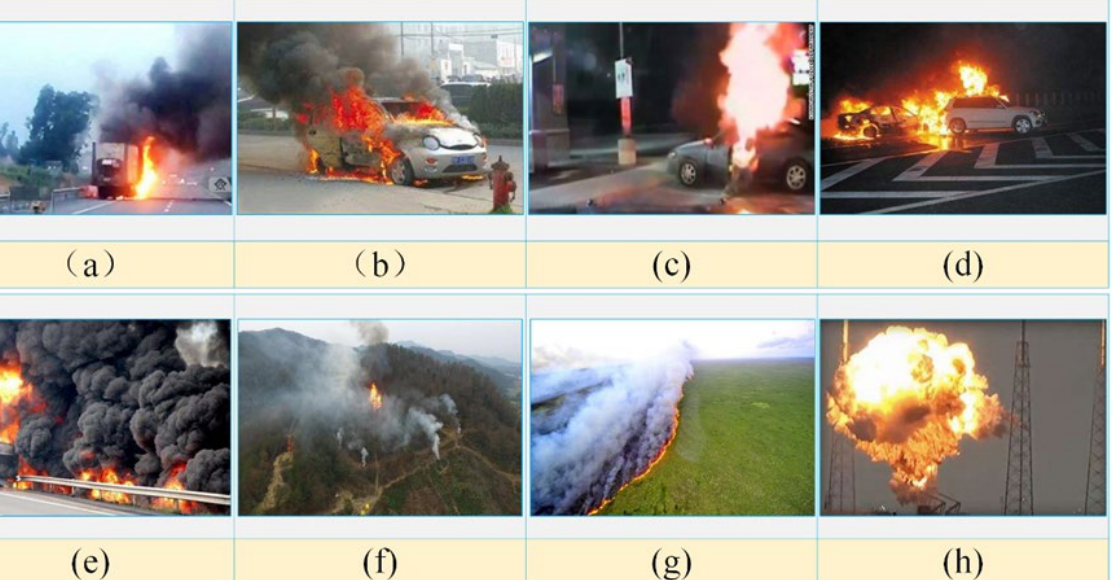
Table 1. Electric vehicle flame dataset information.